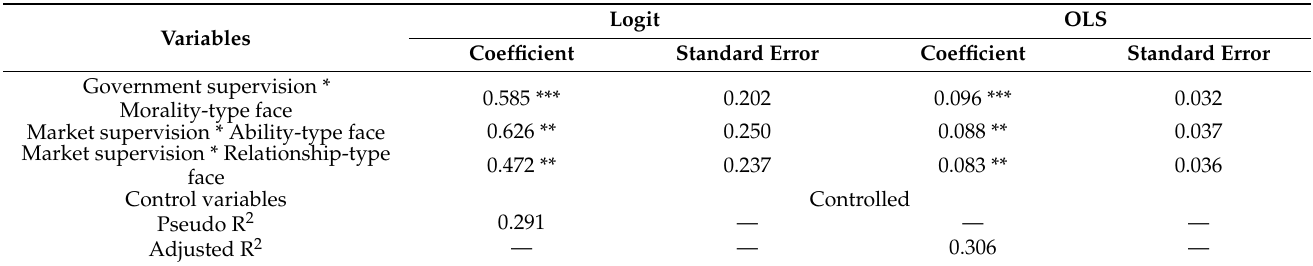
Table 5. The effect of the interaction terms of external-supervision- and face-consciousness-related variables on pesticide safety